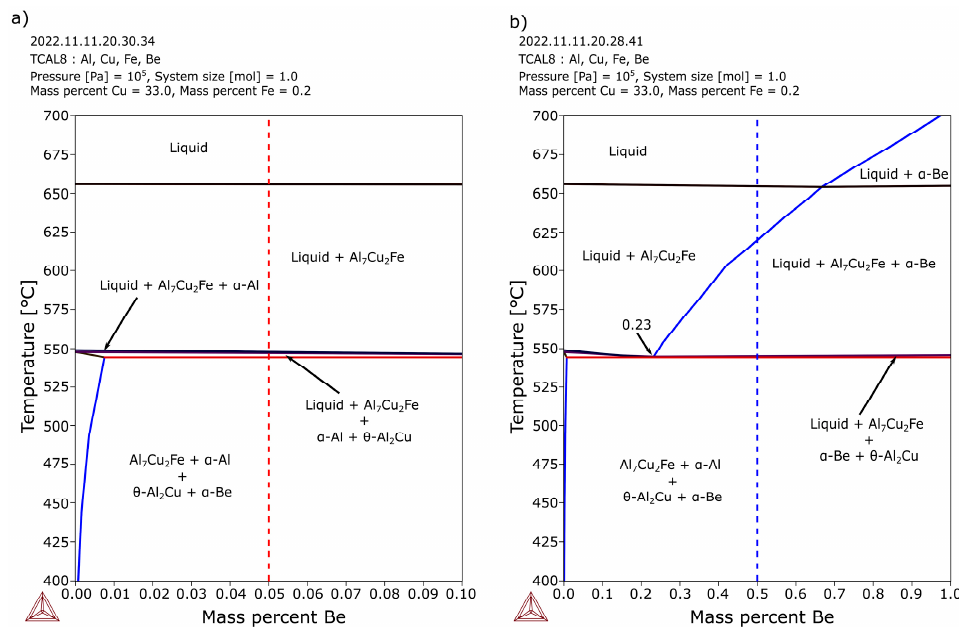
Figure 3. Partial pseudo-binary phase diagram Al-33 wt.%Cu-0.2 wt.%Fe − xBe with dashed lines indicating the compositions of the analyzed alloys ( a ) Al-33 wt.%Cu-0.2 wt.%Fe − 0.05 wt.%Be and ( b ) Al-33 wt.%Cu-0.2 wt.%Fe − 0.5 wt.%Be (Thermo-Calc 2021b, TCAL8